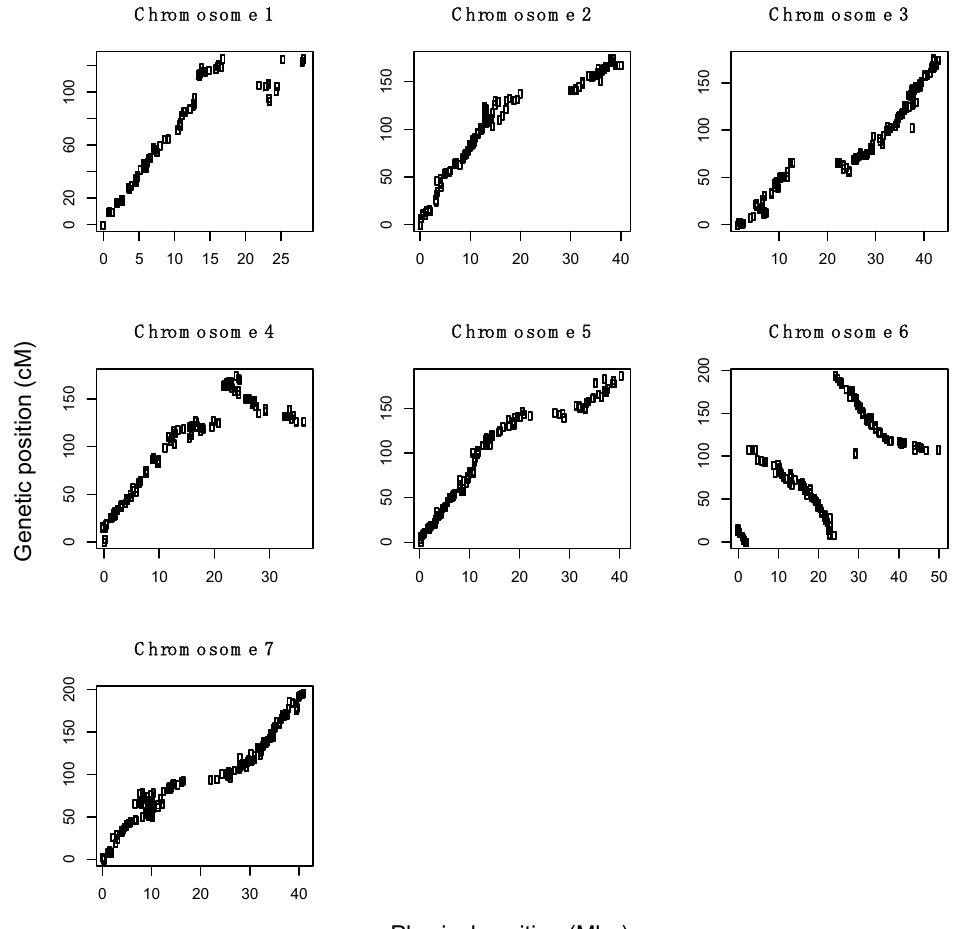
Figure 3. Genetic position plotted against physical genomic position for 974 combined SNP and SSR markers. A reduced slope and gap between groups of markers suggest reduced recombination and few markers near the centromere. Discontinuous portions in chromosomes 1, 4, and 6 suggest misalignments within either the linkage maps or the current genome assembly.